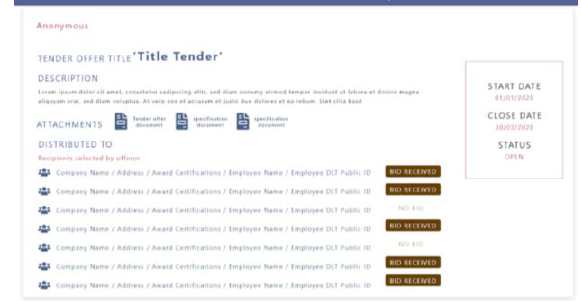
Figure A2. Details of a tender offer